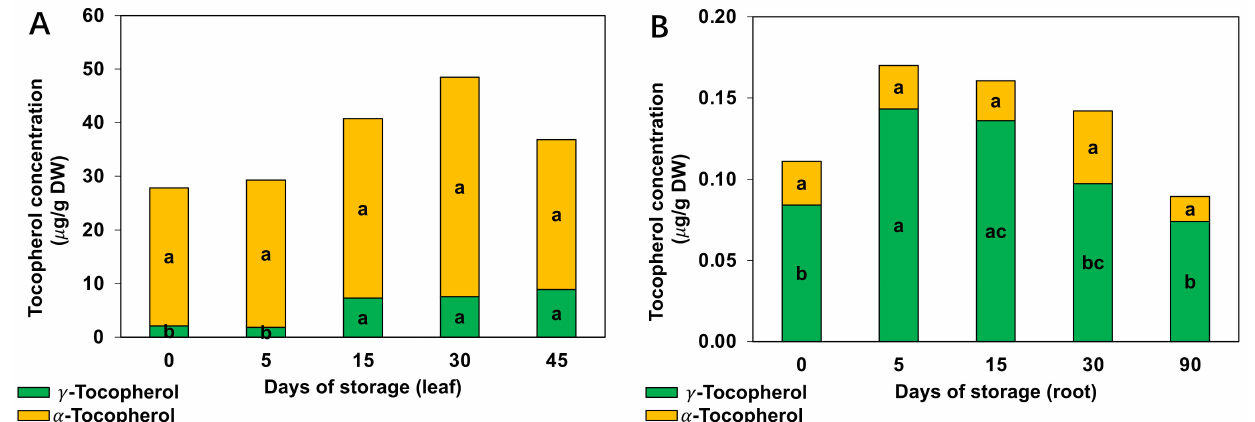
Figure 3. Alpha- and gamma tocopherols concentration changes in detached leaf ( A ) and topped radish root ( B ) during 1 ◦ C cold postharvest storage. Mean is expressed as from triplicates (n = 3). Different letters indicate significant difference across different days of storage within the same compound at p = 0.05 by Tukey’s